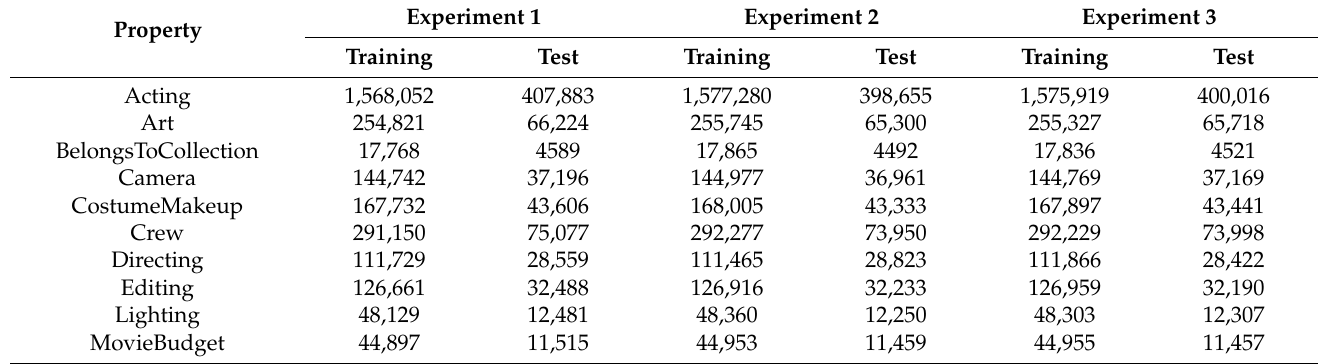
Table 7. The number of instance triples used in the